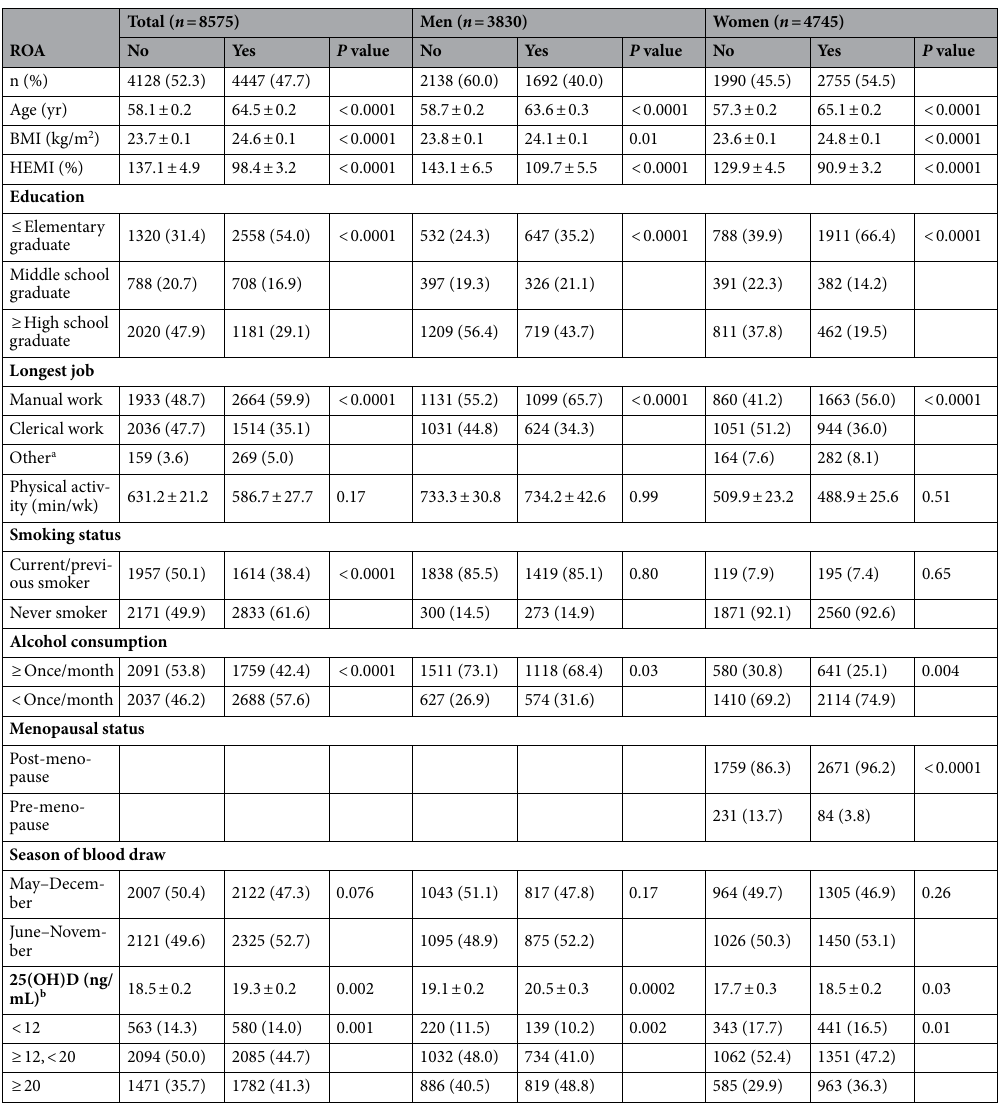
Table 1. Characteristics of adults 50 years and older in KNHANES 2010–2013 by ROA status. Joints assessed for ROA include the knee, lumbar spine, and hip. Data are shown as weighted mean ± standard error or unweighted n (weighted percentage). Differences in characteristics were investigated with weighted Rao- Scott χ 2 or independent t -test. The total percentages may exceed 100% due to rounding. Sample weights were applied according to the directions of the KNHANES. BMI, body mass index; HEMI, household equivalent median income; KNHANES, Korea National Health and Nutrition Examination Survey; ROA, radiologic osteoarthritis; wk, week; yr, year; 25(OH)D, 25-hydroxyvitamin D. a Includes unemployed and housewives. b Serum 25(OH)D was log-transformed due to the absence of